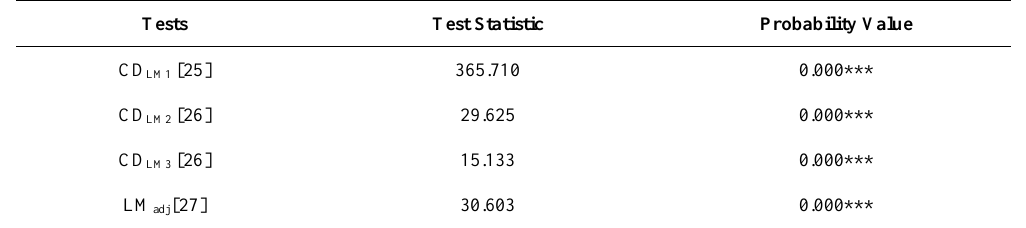
Table 3. Cross Section Dependency Test Results